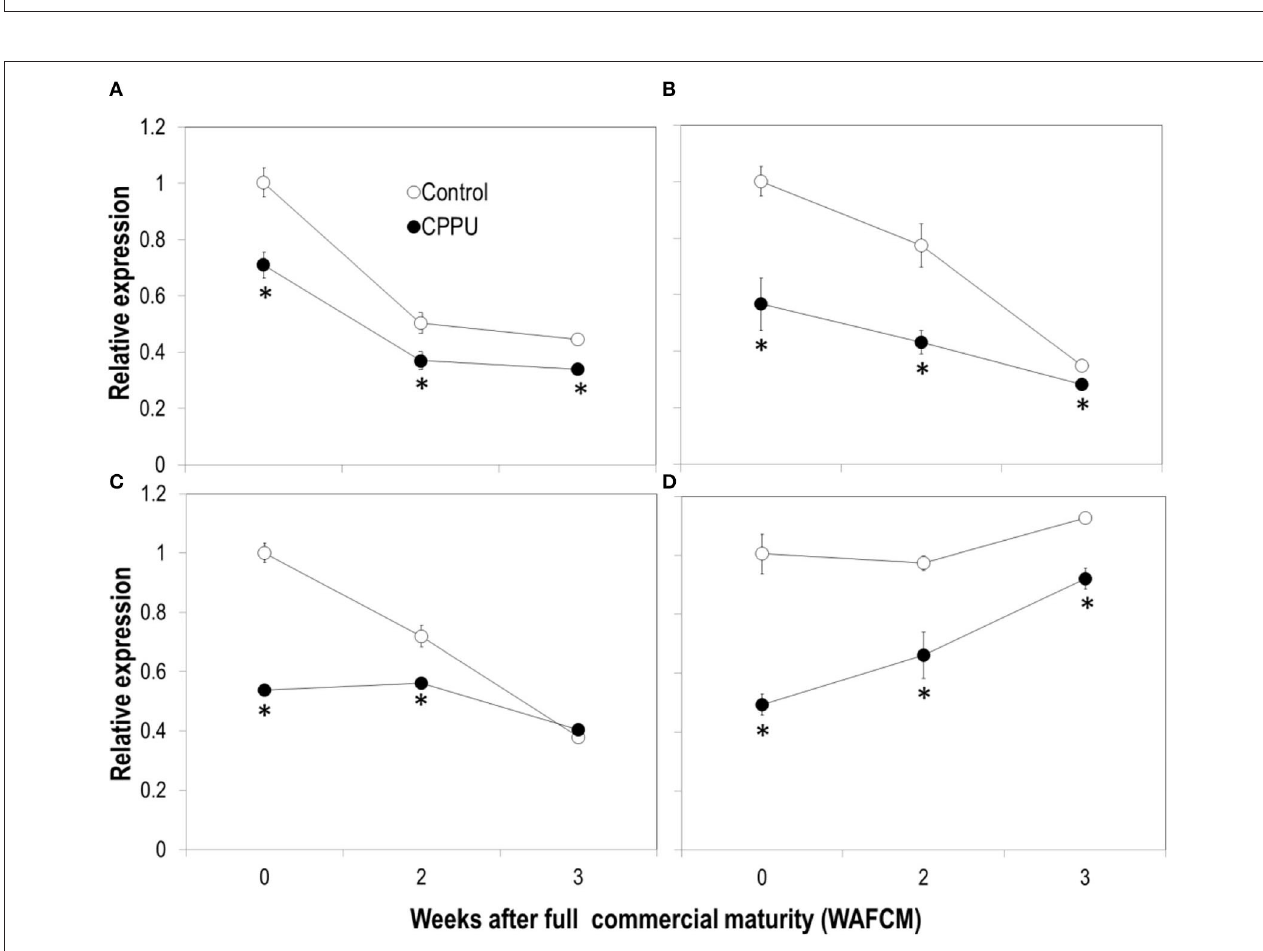
FIGURE 11 | Effects of preharvest application of CPPU on expression of genes encoding pyruvic decarboxylase (PDC) [ (A) LcPDC1 ; (B) LcPDC2 ] and ADH [ (C) LcADH1 , (D) LcADHL1 ]. Vertical bar at each data point stands for standard error ( n = 5). *Indicates significant difference between CPPU treatment and the control at p < 0.05, Student’s t